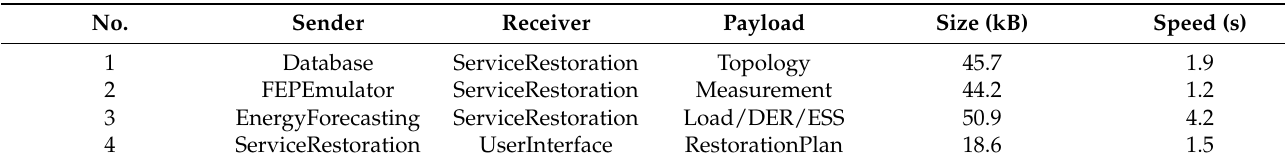
Table 3. Data size and speed by